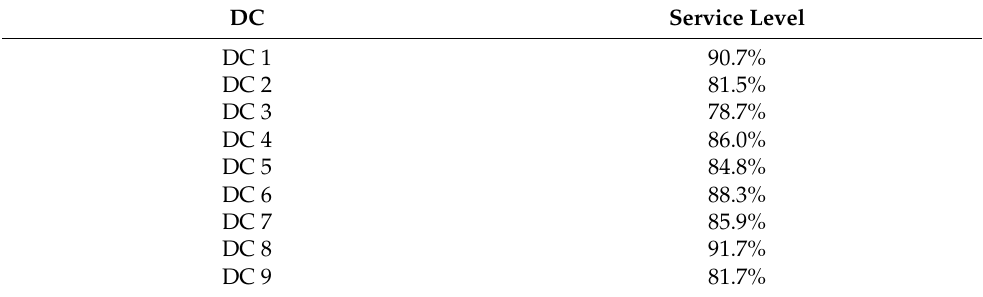
Table 7. Service level by regional